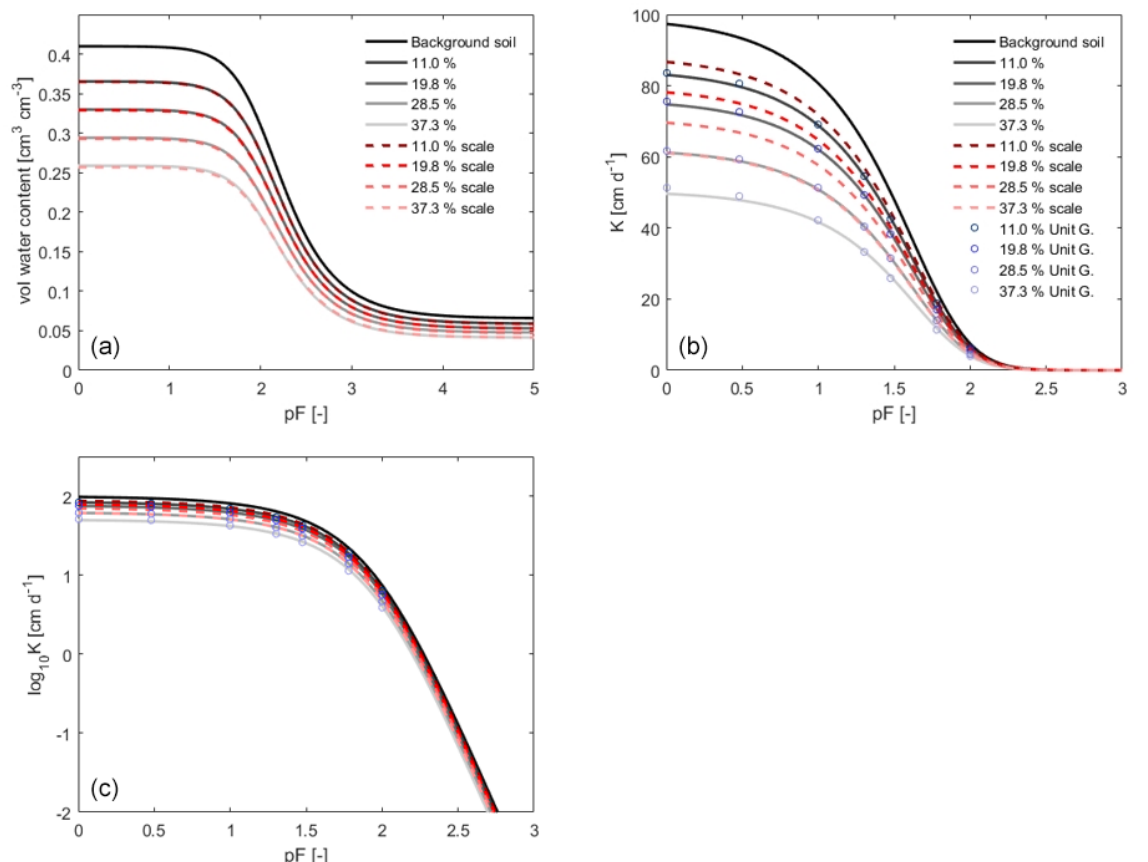
Figure 5. The WRCs and HCCs of the background soil (solid black line) and the identified effective WRCs (a) and HCCs (b) of the virtual stony soils (solid gray lines) with different values of f . The HCCs are also presented on a logarithmic scale. The dashed lines show the effective WRCs and HCCs calculated by the models of Bouwer and Rice (1984) and Ravina and Magier (1984). The circles on the HCCs present the data points of hydraulic conductivity obtained by the virtual MSUG experiment under near-saturated conditions up to pF ≈